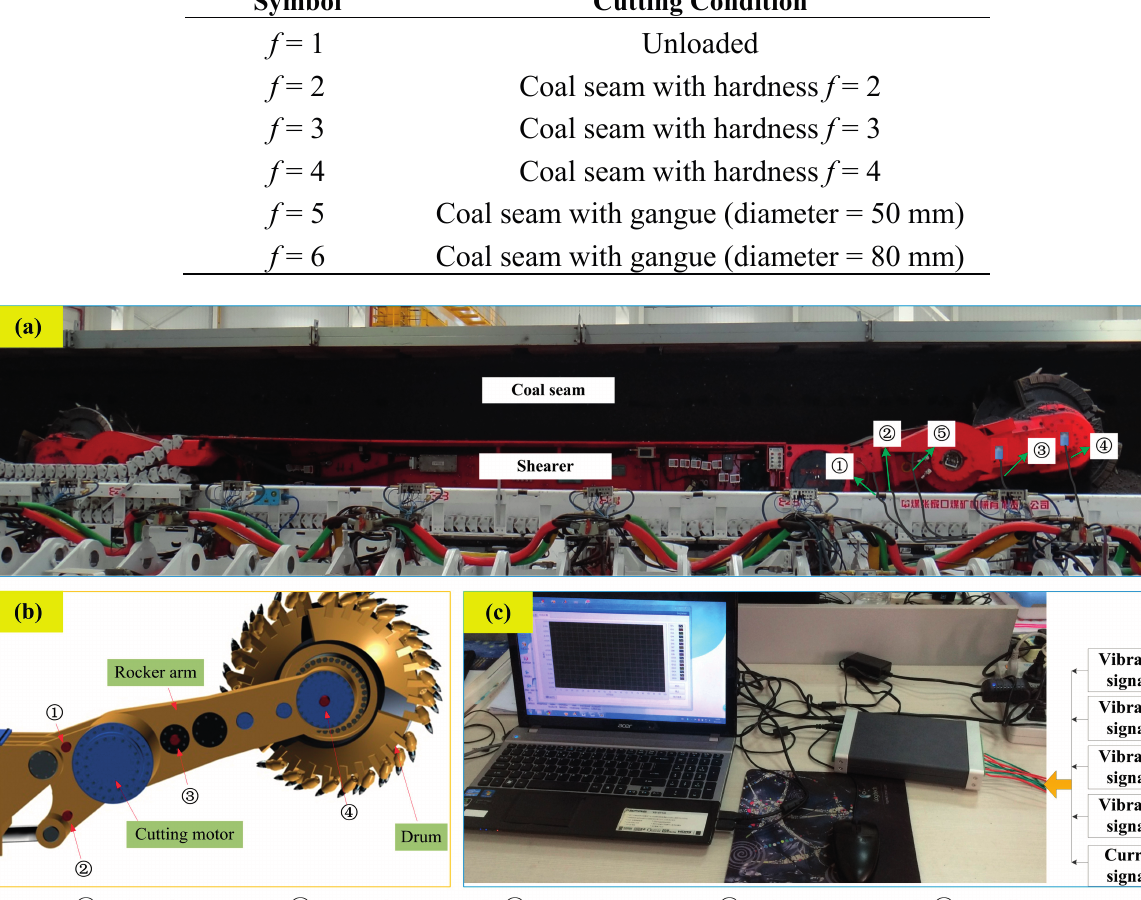
Figure 3. Self-designed experimental system for shearer cutting coal: ( a ) The experiment bench of shearer cutting coal; ( b ) The installation sketch of accelerometers; ( c ) Sensor signals processing